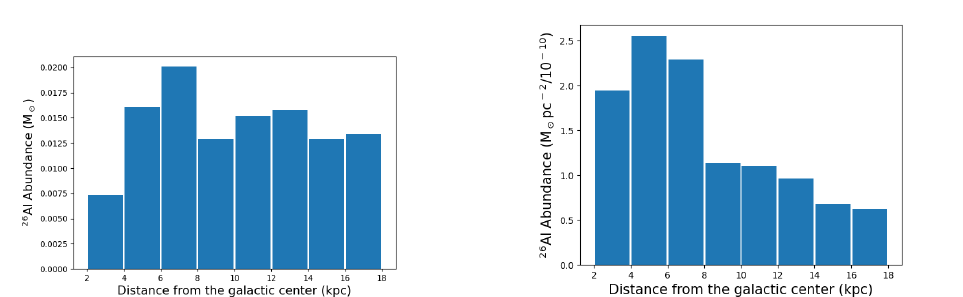
Figure 1. (Left) Absolute abundance of 26 Al abundance, (Right) 26 Al per unit area in the Galaxy for eight annular rings from 2-18 kpc.